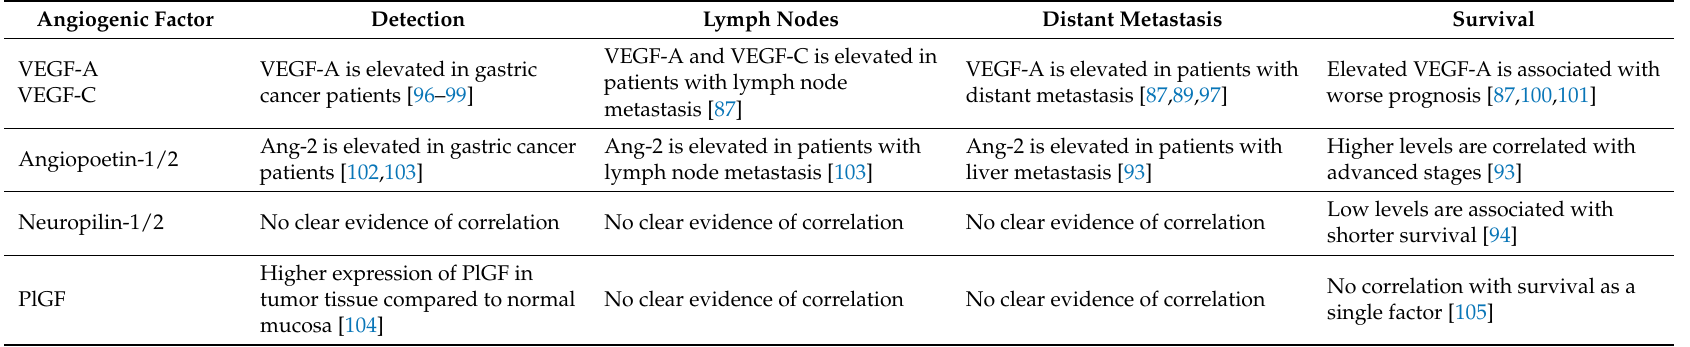
Table 1. Potential biomarkers predicting survival and metastasis in gastric